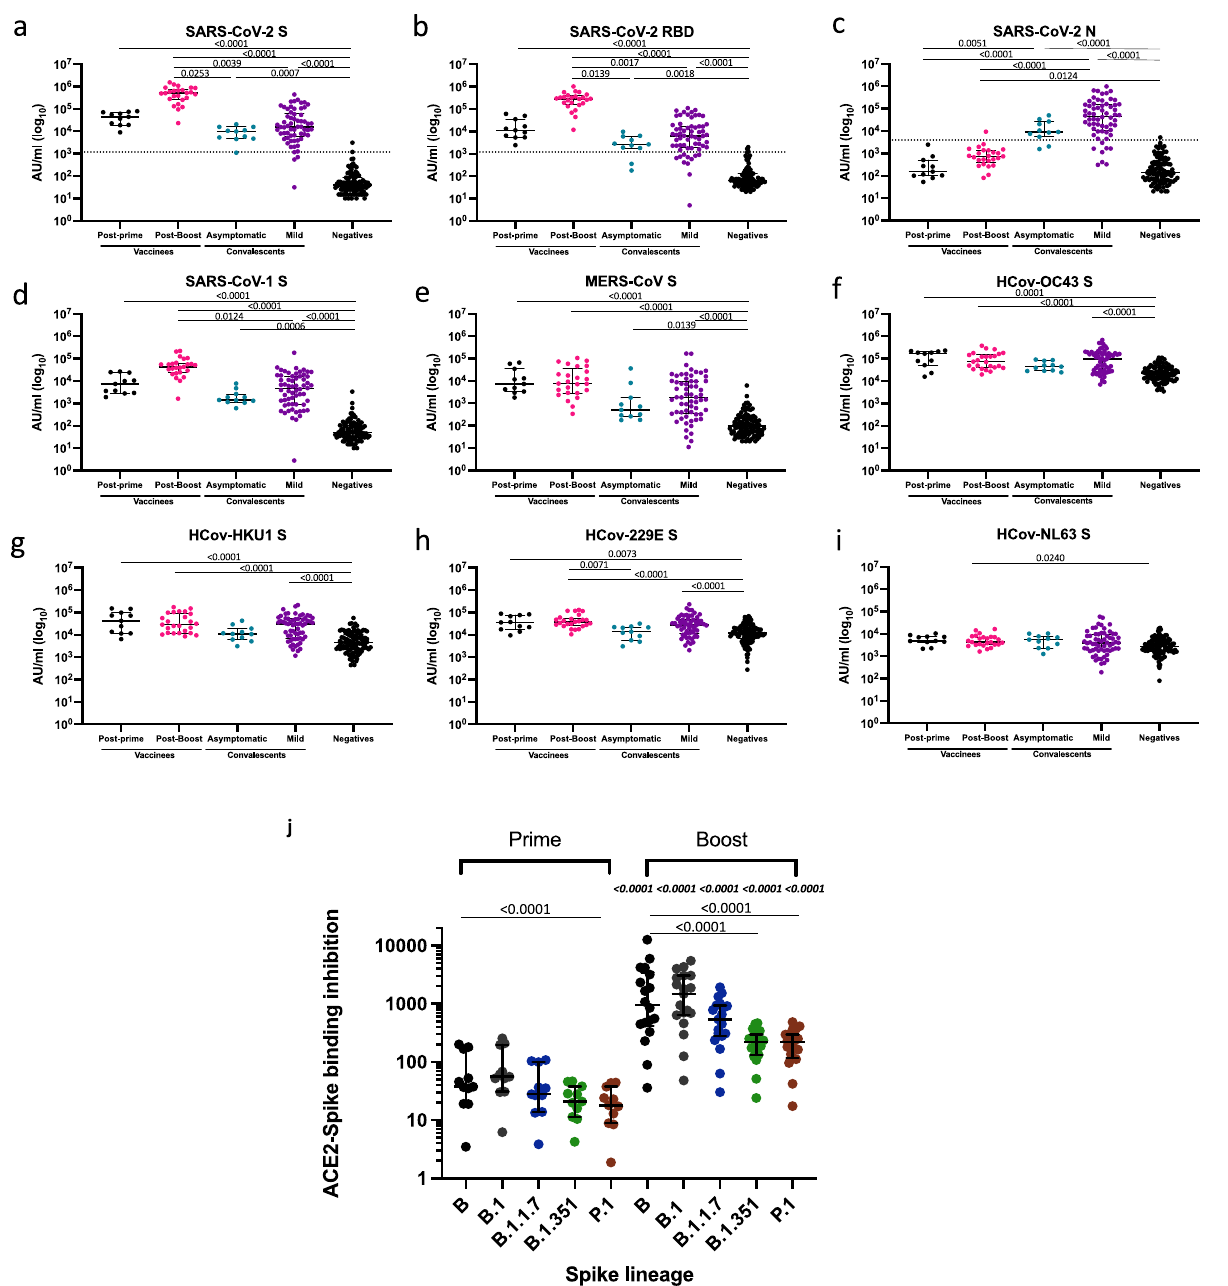
Fig. 2 Binding assays. IgG antibodies speci fi c to; a – c SARS-CoV-2 (spike [S], receptor-binding domain [RBD], nucleocapsid [N]), d , e SARS-CoV-1 S, MERS-CoV S, f – i HCoV-OC43 S, HCoV-HKU1 S, HCoV-229E S, HCoV-NL63 S, were measured using an MSD technology platform customised array. Sera analysed were from vaccinees (post-prime and post-boost), asymptomatic (mean 27 days post-PCR positive test, range 22 – 33 days) and mild COVID-19 convalescent sera (mean 29 days post-symptom onset, range 18 – 40 days) and a cohort of prepandemic sera collected between 2014 and 2018 negative for SARS-CoV-2 (negatives). Data are displayed as calculated concentrations which use an MSD standard reference curve to interpret arbitrary units (AU). Statistical difference between the groups was performed using a two-tailed Kruskal – Wallis one-way ANOVA with Dunn ’ s post-test for multiple comparisons made to compare all groups (signi fi cant adjusted P values are displayed). Vaccinees post-prime n = 11; vaccinees post-boost n = 25; negatives n = 103; asymptomatic COVID-19 convalescents n = 11; mild COVID-19 convalescents n = 62. The dashed lines in a – c show the cut-offs determined as the mean of negatives + 3 SD. Samples were run in monoplicate (convalescent samples) or duplicates (vaccine samples). j Inhibition analysis between ACE2 and recombinant spike from the designated homotypic and heterotypic lineages. Sera derived from individuals receiving prime or boost vaccination: post- prime n = 11, post-boost n = 18 – 25 dependent on spike variant. Differences between B and other variants in post-prime and post samples were tested using a Friedman statistical test with Dunn ’ s multiple comparison test (signi fi cant P values are displayed on lines linking B to variant). A two-tailed Mann – Whitney U test was used to compare post-prime and post boost groups for each variant. P values are displayed on the boost panel, immediately above each variant and are italicized. Plots show median with error bars indicating ± intraquartile range) (IQR). ACE2 inhibition assay samples were run in